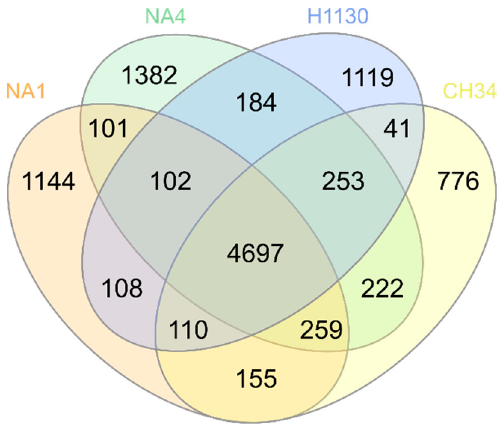
Figure 3. Venn diagram displaying the distribution of shared MicroScope gene families (MICFAM) among C. metallidurans CH34, NA1, NA4 and H1130.